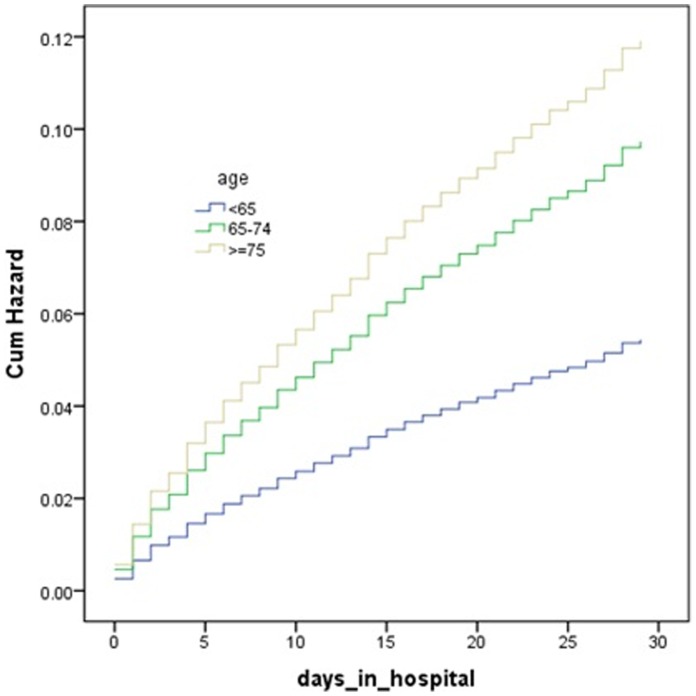
Predicted cumulative hazard of 30 days mortality in different age groups of patients.The curves were constructed according to the age groups with the use of Cox regression analysis.